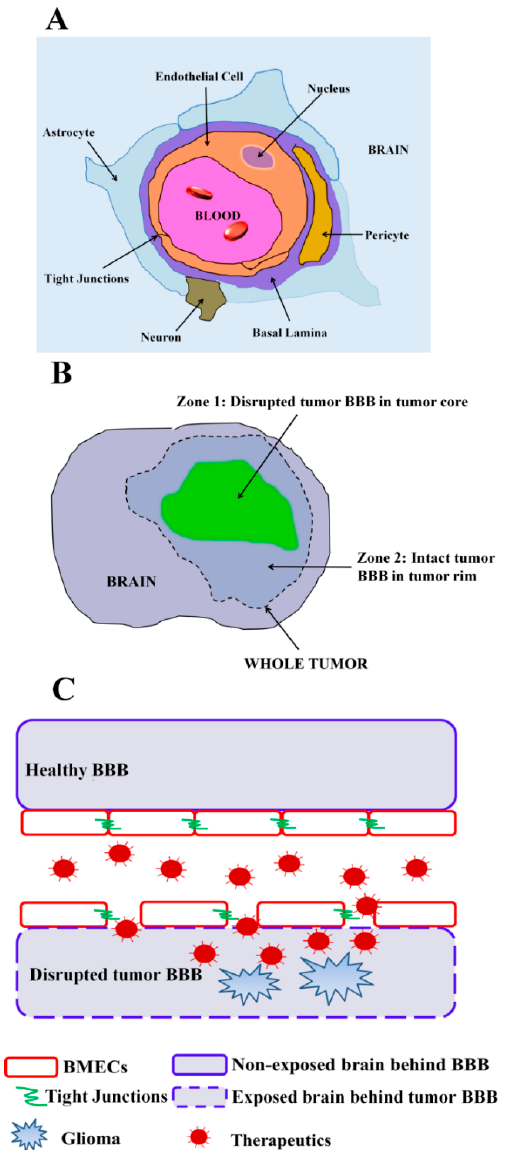
Figure 1. ( A ) Cross-sectional view of the neurovascular unit with the brain endothelial cells forming the blood–brain barrier (BMECs). Brain endothelial cells are connected by adherens and tight junctions, share a basement membrane with pericytes, make contacts with astrocyte endfeet and respond to neuronal cues. ( B ) Cartoon representation of the heterogeneity of tumor BBB permeability in glioma. Two zones can often be observed within the tumor volume—zone 1: disrupted tumor BBB in the tumor core imaged via MRI contrast leakage; zone 2: intact tumor BBB in the tumor rim area. ( C ) Cartoon depiction of drug delivery through normal and pathologically disrupted tumor BBB. Under normal conditions, the healthy and intact BBB separates the CNS from blood components, thereby preventing therapeutics from accessing the CNS. Under conditions in which glioma induces pathologic tumor BBB disruption, therapeutics can access the CNS via passive penetration or actively targeting the exposed components behind the disrupted tumor